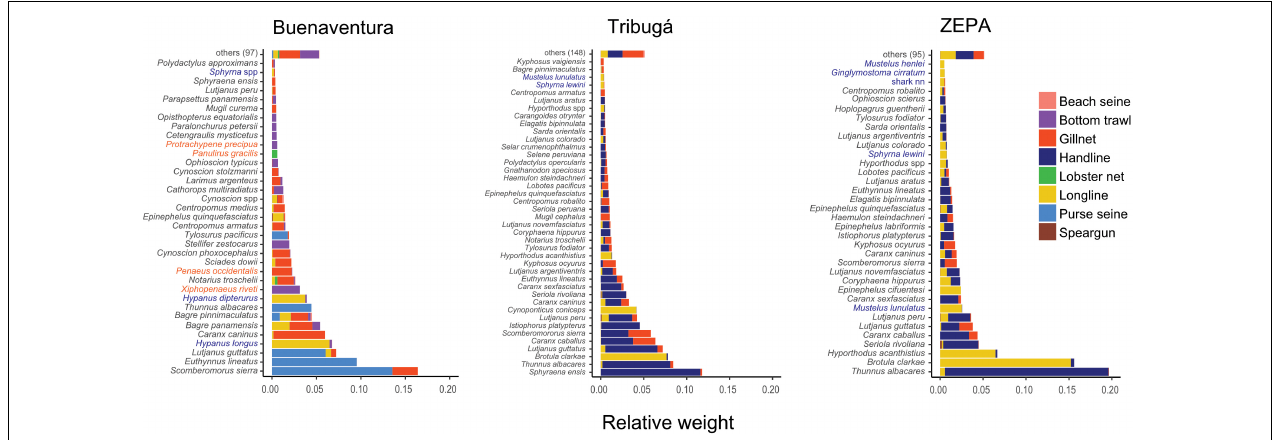
FIGURE 3 | Relative weight of taxa in the catch of the SSF at three coastal zones of the Colombian Pacific: ZEPA, Tribugá, and Buenaventura. Taxonomic identity is indicated for those taxa that contributed 95% to total catch and relative catch contribution by each gear type is illustrated. Elasmobranch species (sharks and rays) are shown in blue font, crustaceans in orange and bony fish in